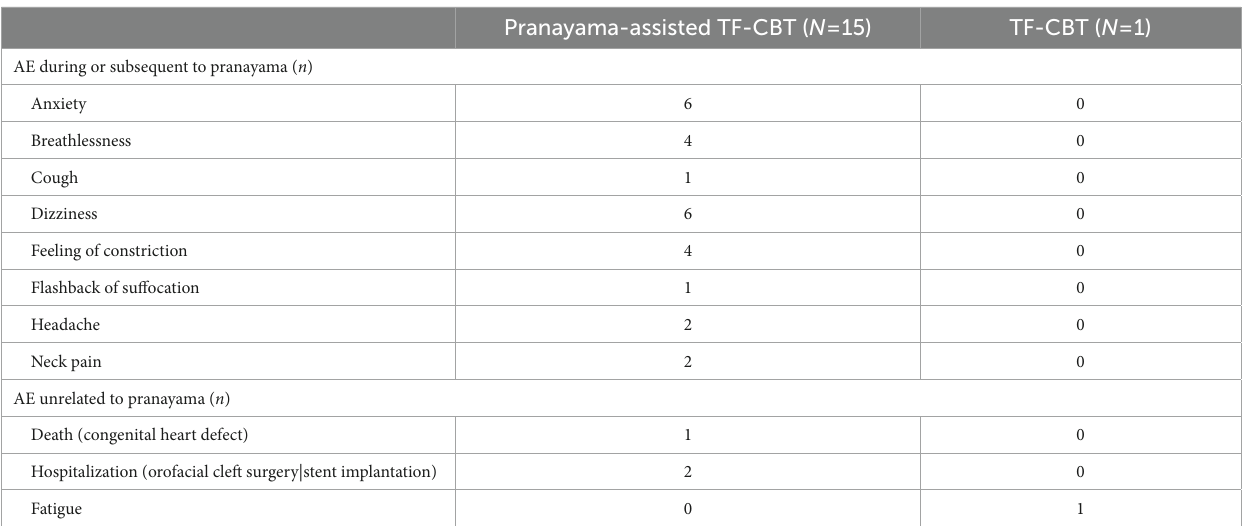
TABLE 1 Number of adverse events.